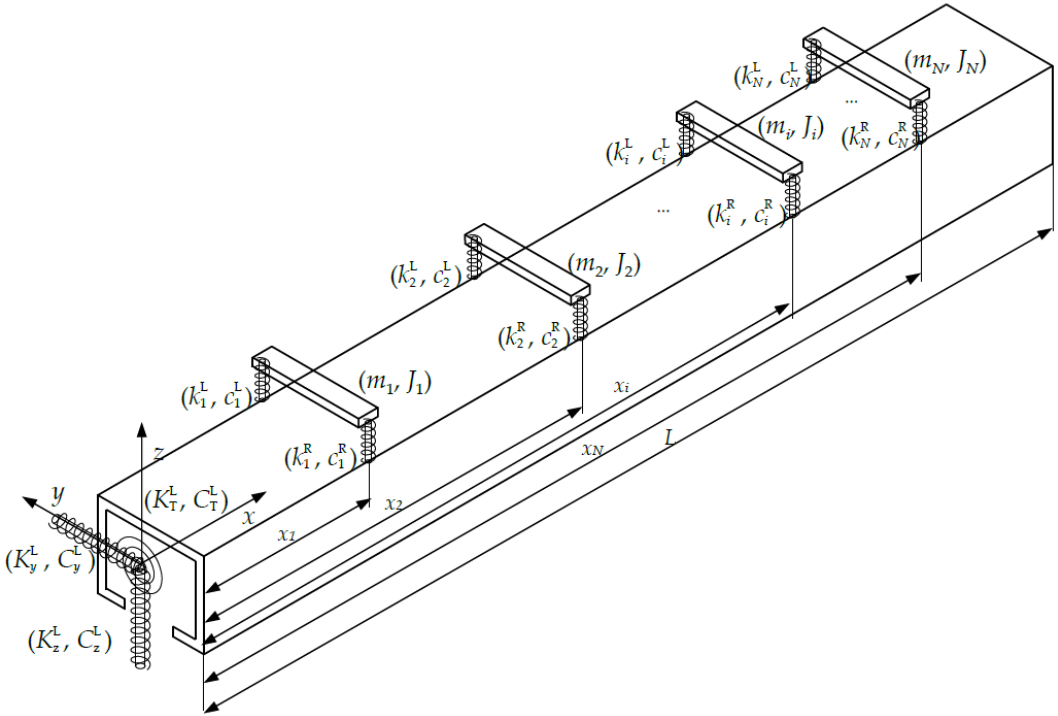
Figure 1. A elastically-damping constraint thin-walled beam carrying a number of spring-damper- mass systems.